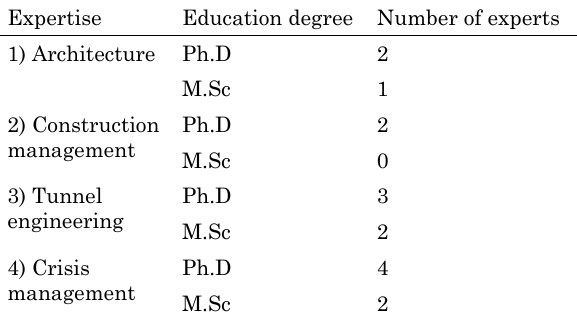
Table 1. Statistics of experts’ community